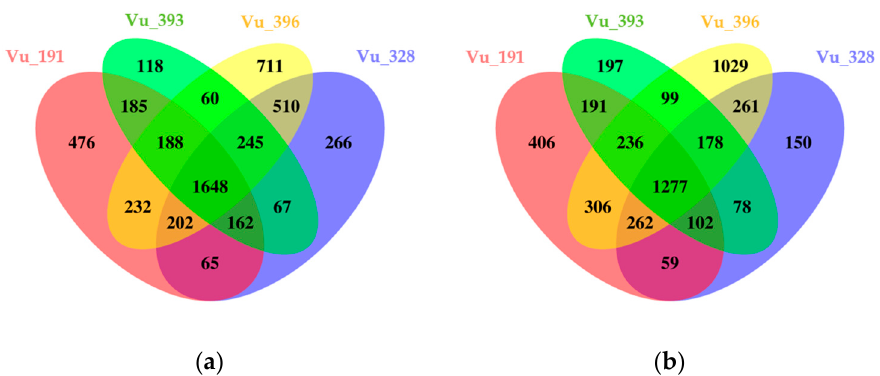
Figure 4. Venn diagrams showing the number of common and specific DEGs identified in cowpea germplasms with different levels of salt tolerance: ( a ) up-regulated and ( b ) down-regulated DEGs.